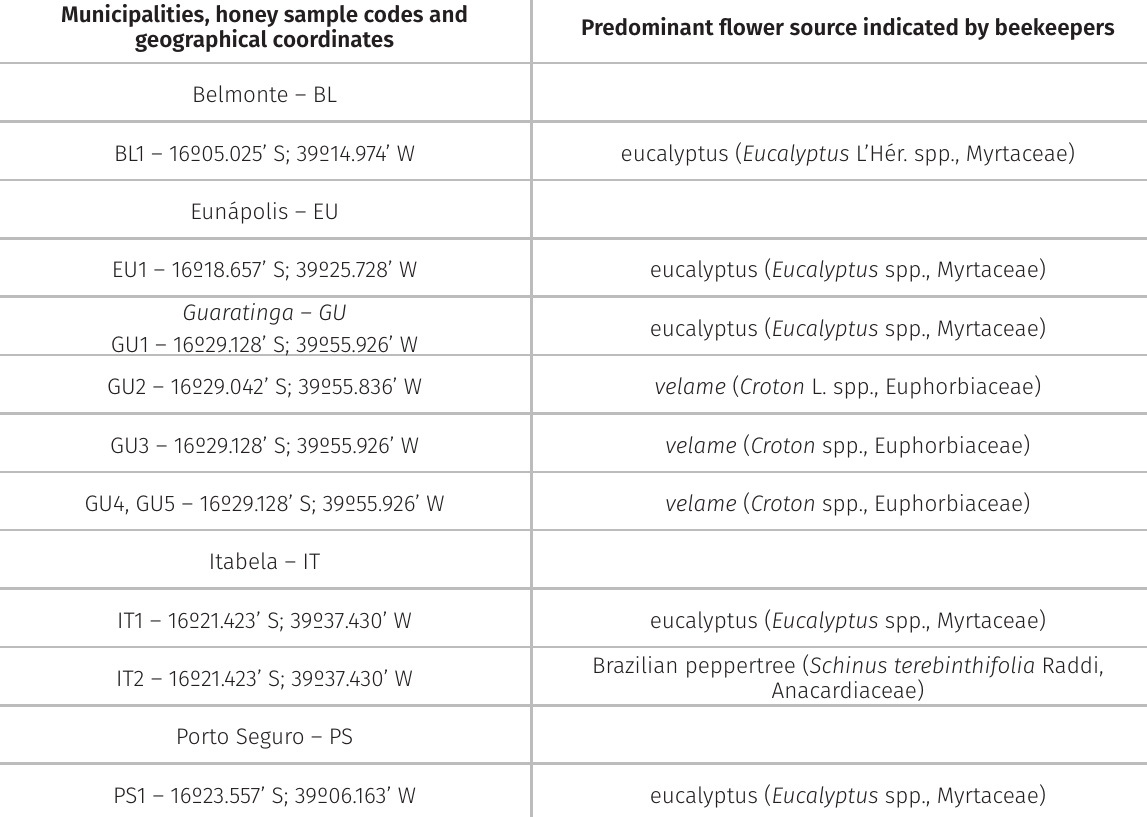
Table I. Municipalities of the Discovery Coast (Bahia, NE Brazil), honey sample codes, geographical coordinates of the apiaries, and predominant flower sources indicated by the beekeepers for each honey sample. Municipalities, honey sample codes and geographical